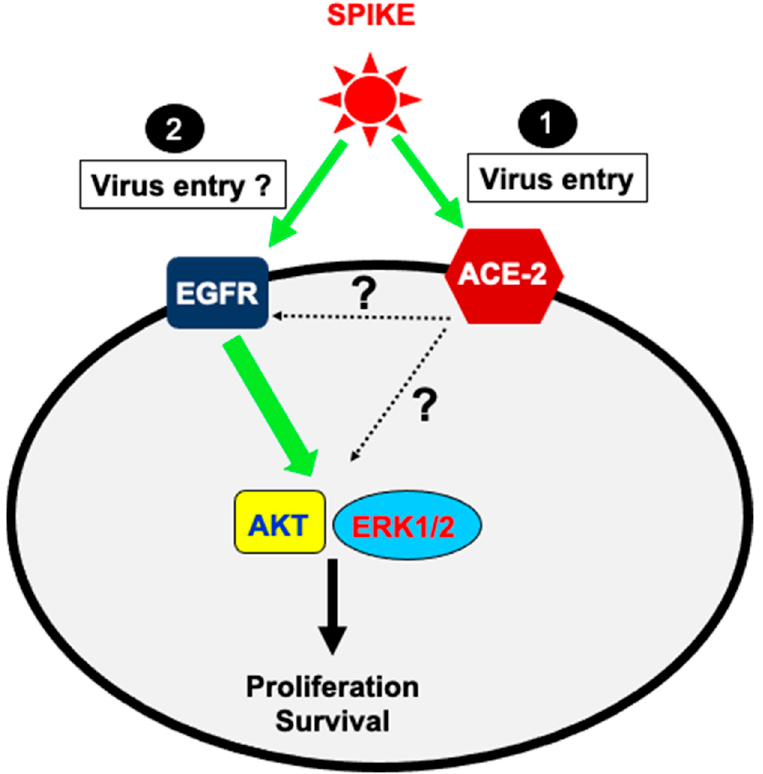
Figure 6. Speculative model for the targeting of EGFR and its downstream signaling by SARS-CoV-2 spike 1 protein.